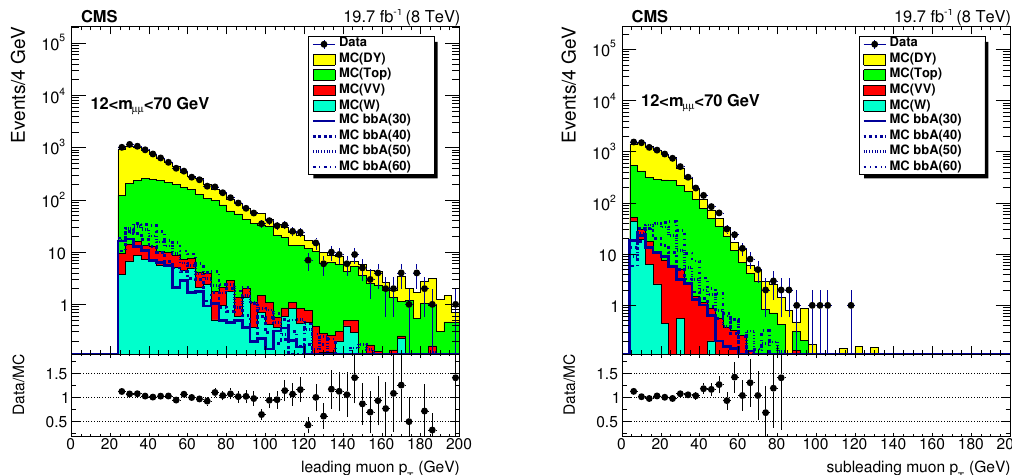
Figure 1 . The transverse momentum of the leading (left) and the subleading (right) muon for data (dots) and simulation (histograms). The histograms for simulated backgrounds are stacked. The histogram labeled as MC(Top) shows the sum of the single top and top quark pair production processes. The expected signal is shown assuming a signal cross section times branching fraction of 350 fb. The background is normalized to the number of events expected from simulation. In the lower panel, the ratio of the number of events in data and background simulation is shown.